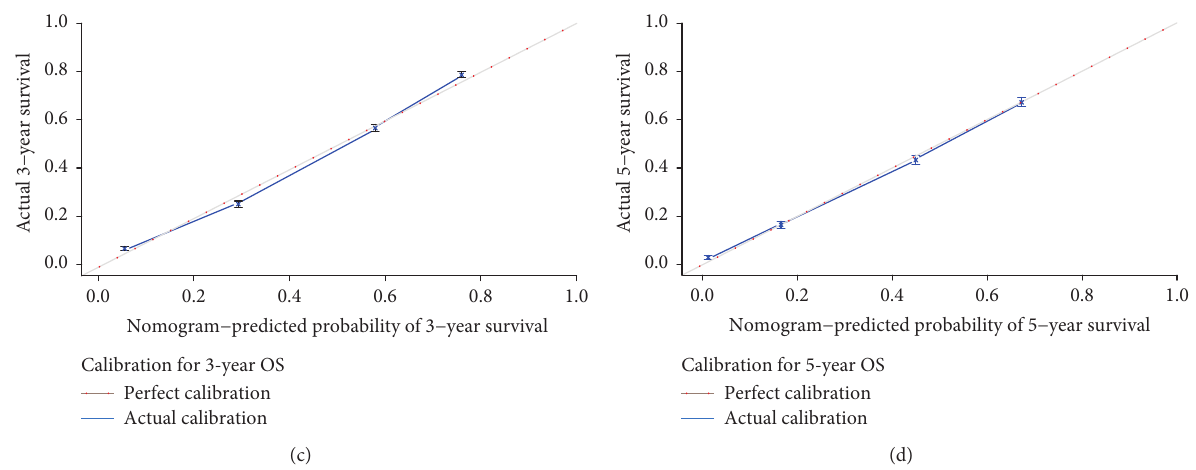
Figure 3: Calibration plots of nomogram in both groups. (a and b). The nomogram was calibrated in the training group by predicting the 3- and 5-year survival. (c and d). The nomogram was also calibrated in the validation group by predicting the 3- and 5-year survival. All results showed better fitting